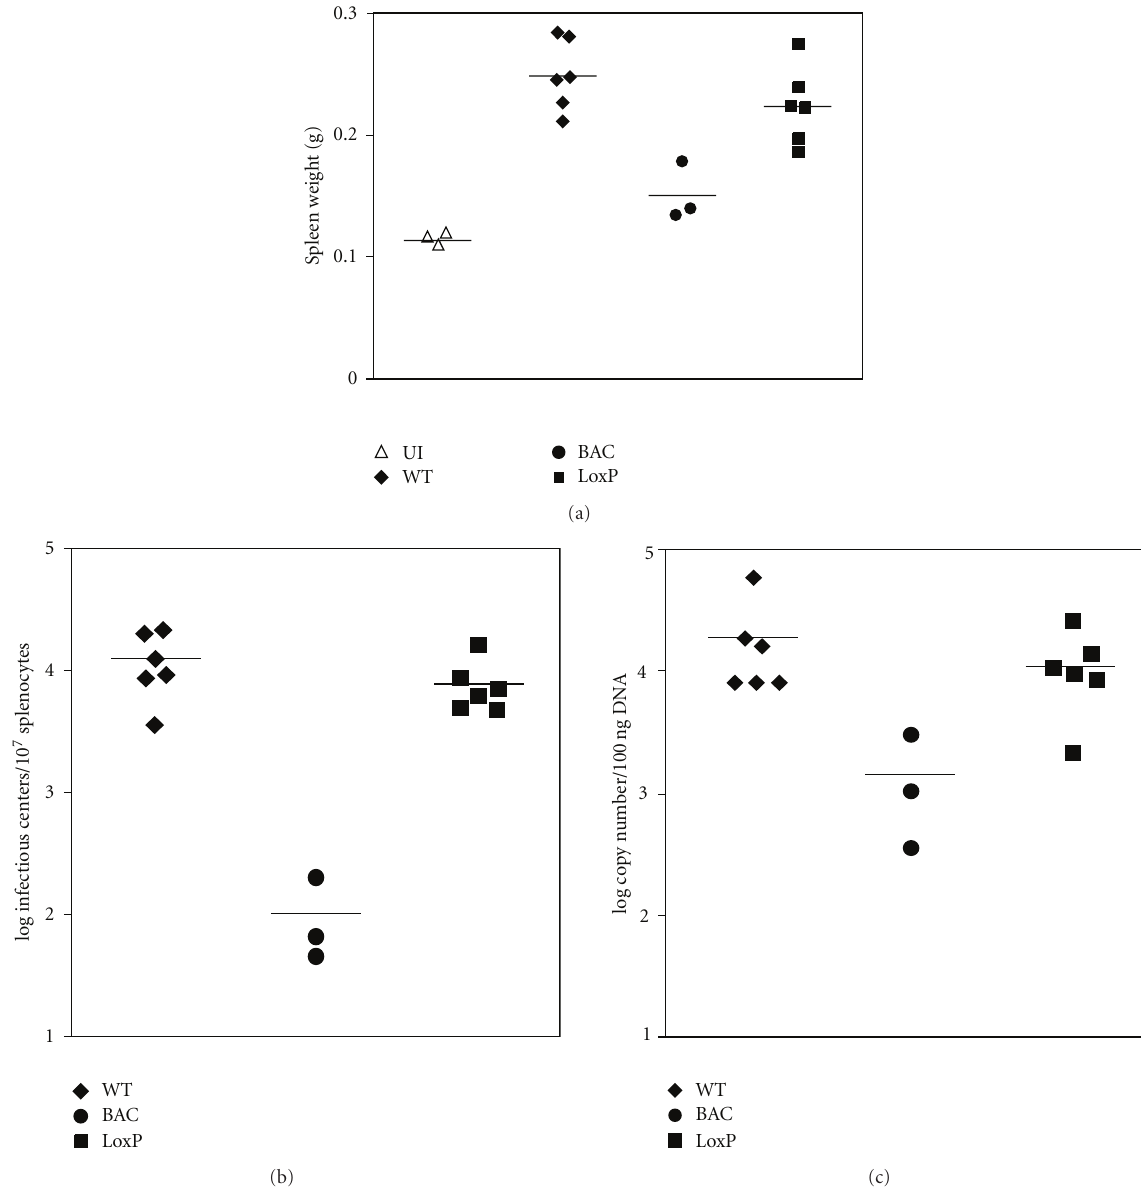
Figure 4: The removal of the BAC insert restored the ability of MHV-68 to establish viral latency in the spleens of mice. Balb/c mice were infected with 20PFU of each virus via intranasal inoculation. At day 14-15 after infection, the spleens were weighed and harvested for reactivation assays and quantification of viral DNA copy numbers. Each symbol represents the weight of the spleen (a), the number of infectious centers (b), and the viral DNA copies (c) of individual